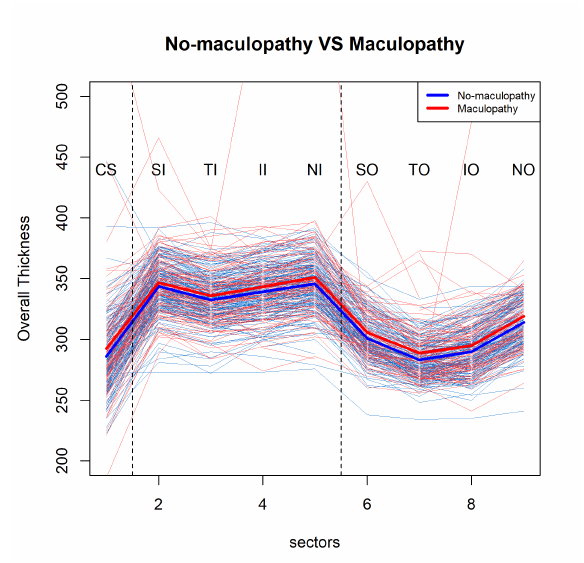
Figure 2. Pairwise comparisons for no-maculopathy and maculopathy eyes mean profiles of retinal overall thickness over 9 sectors (the smaller